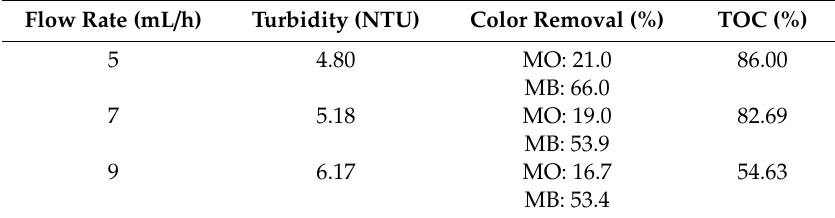
Table 1. Parameters studied for polishing of synthetic secondary e ffl uent. Flow Rate (mL / h) Turbidity